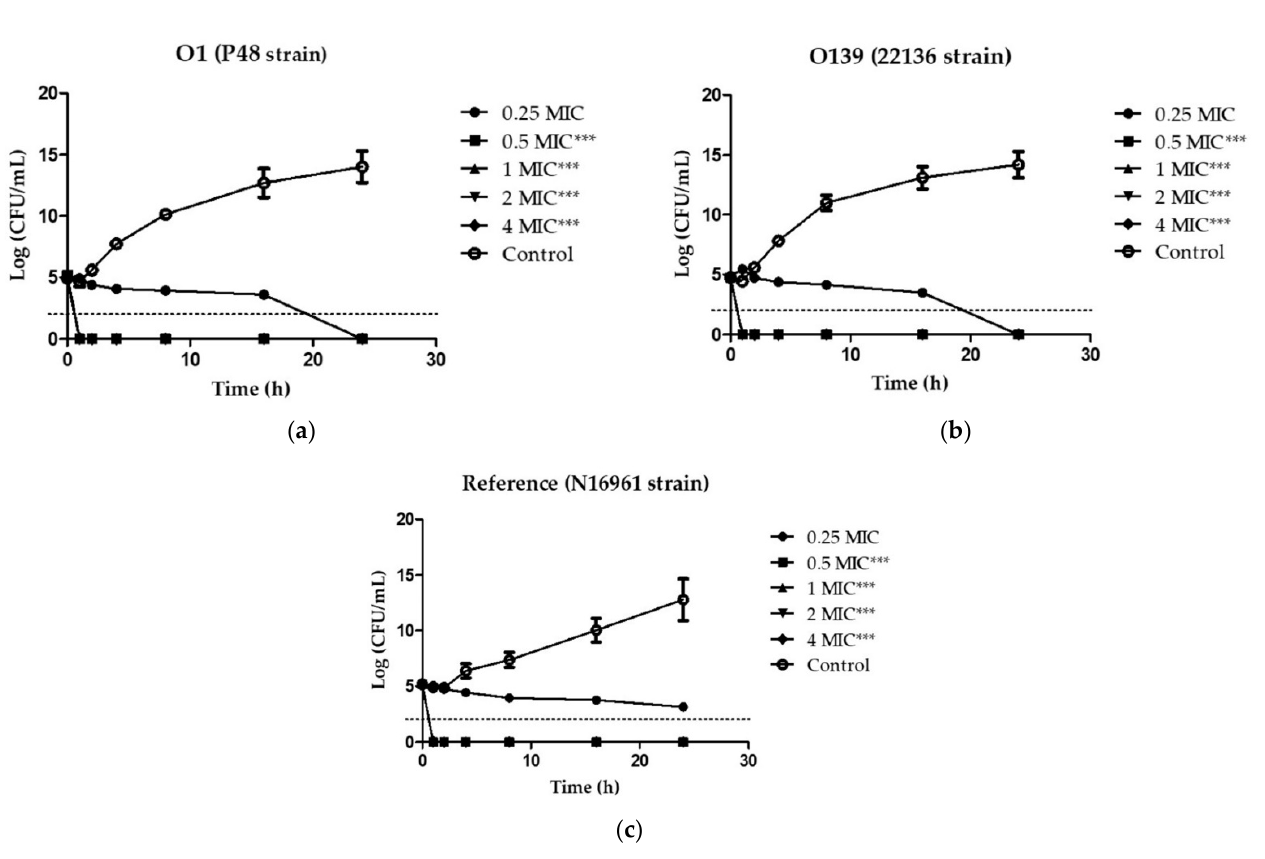
Figure 1. Effect of EGCG on the viability of V. cholerae . Time-kill kinetics of V. cholerae O1 ( a ), O139 ( b ) and reference strain ( c ) at concentrations of 0.25× to 4× MIC against V. cholerae were investigated over a 24 h incubation period at 37 °C. The MIC for EGCG were 125 µg/mL for all strains. MHB was used as the control instead of compound. Samples were taken at 1, 2, 4, 8, 16, and 24 h, to determine viable bacterial numbers. The bactericidal level is indicated by the dashed lines. Significant differences compared to untreated controls at 1 h are indicated by asterisks: *** p < 0.001.